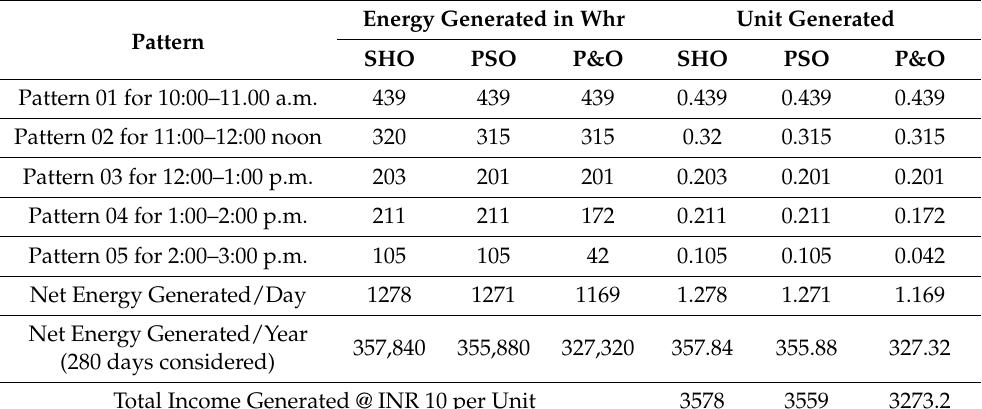
Table 5. Economical Assessment of different